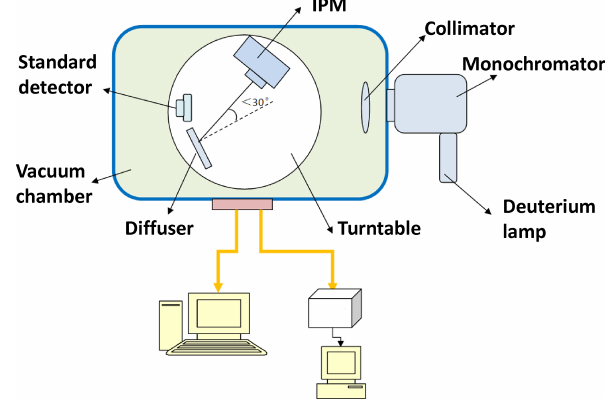
Figure 2. The optical calibration facility at